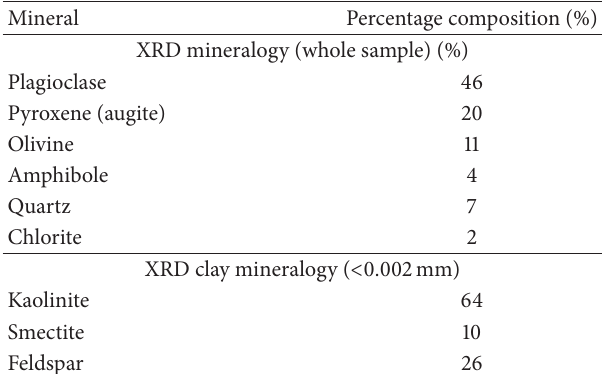
Table 2: Mineral composition of dolerite by